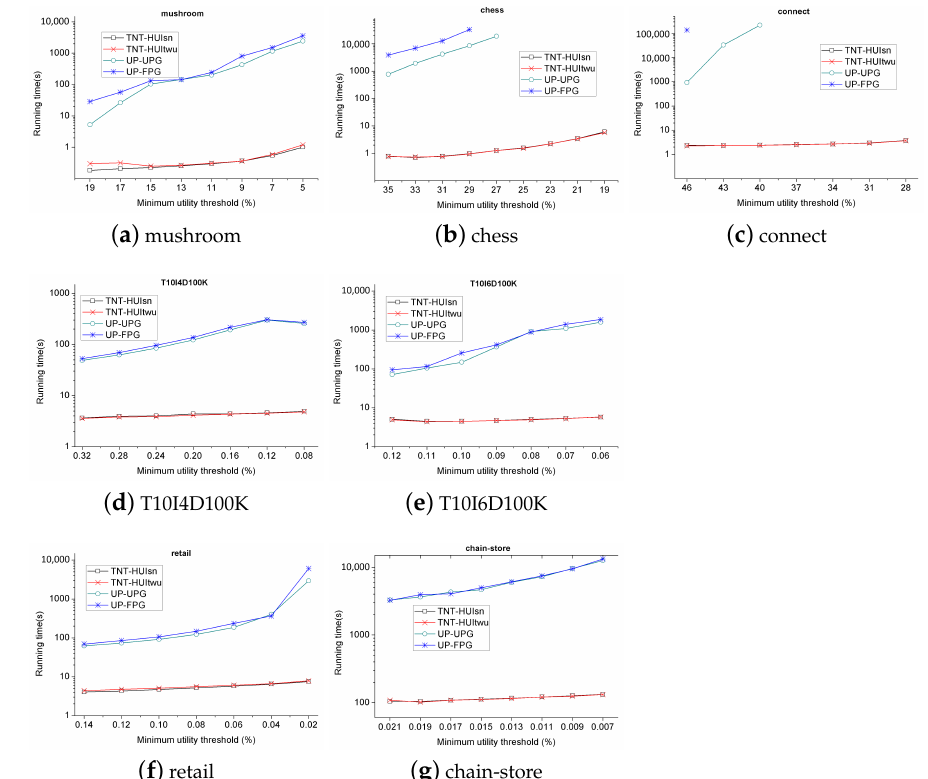
Figure 6. Comparison of running